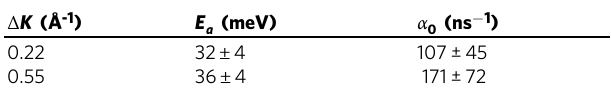
Table 1 Diffusion parameters as determined from the experimental data in Fig.